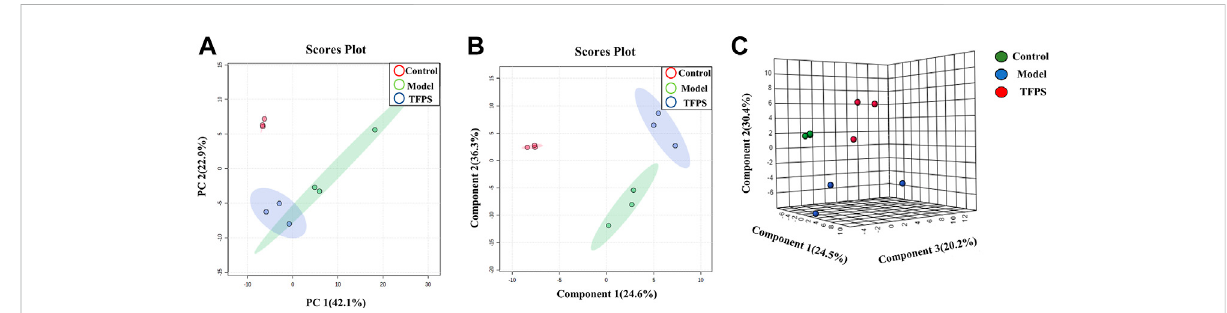
FIGURE 8 PCAandpartialleastsquaresdiscriminantanalysis(PLS-DA). (A) ThePCAscoresplotofPC1( fi rstprincipalcomponent)vs.PC2(secondprincipal component) showing the separation between control group (red), model group (green) and TFPS group (blue); (B) The PLS-DA score plot of control group (red), model group (green) and TFPS group (blue); (C) PLS-DA (3D) spots of control group (green), model group (blue) and TFPS group